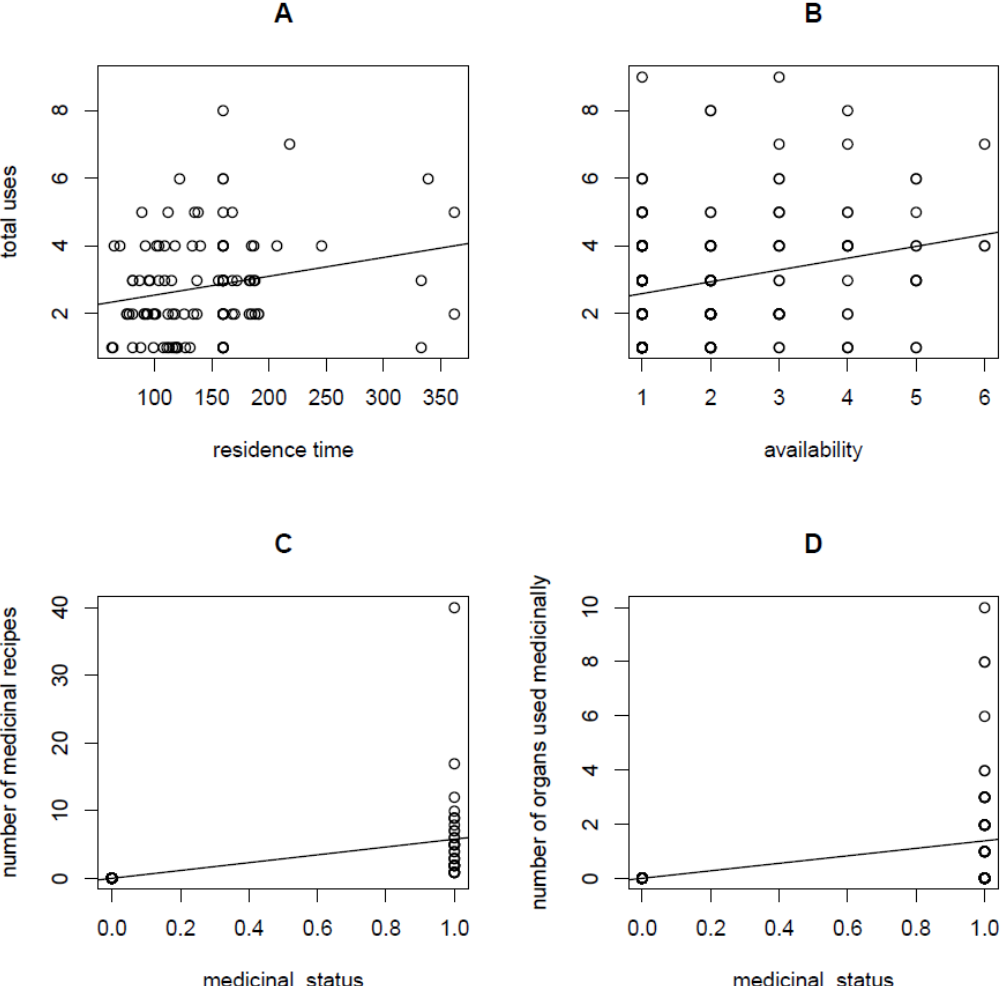
Figure 4. Additional significant relationships in the theoretical framework defining the time-since- introduction theory. Relationship between total uses and residence time ( A ), total uses and availability ( B ), and between number of recipes and medicinal status ( C ) as well as between number of organs used medicinally and medicinal status ( D ).